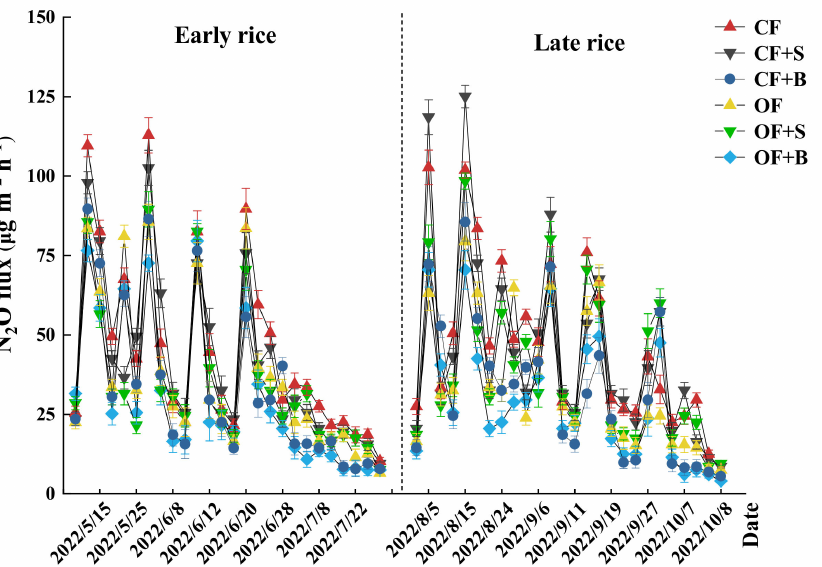
Figure 3. Seasonal variation in the N 2 O emission flux in the double rice cropping system under different treatments. Error bars represent standard deviations ( n =